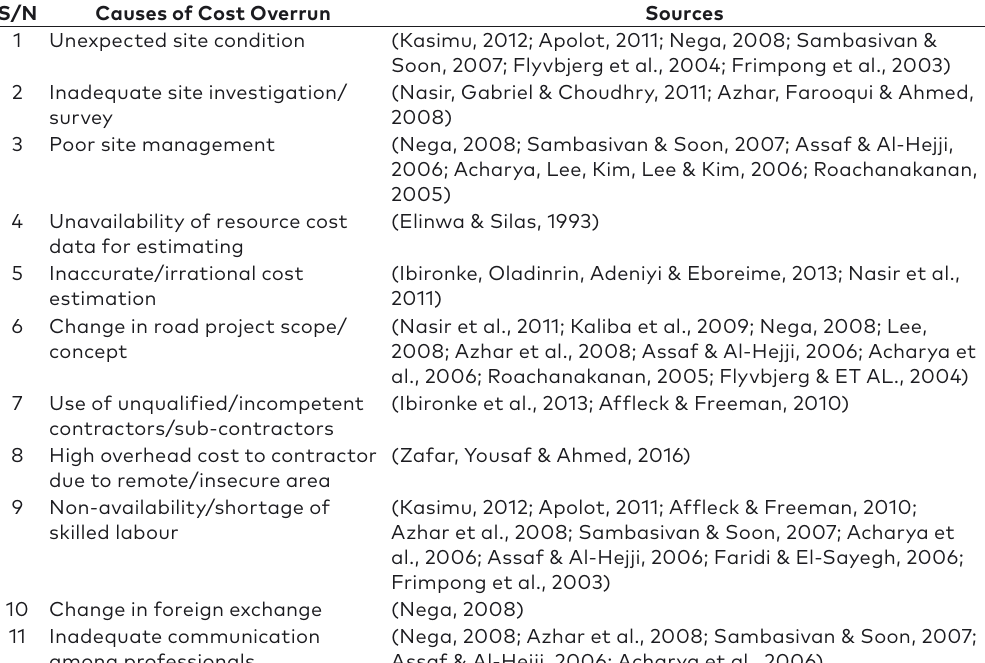
Table 1. Causes of cost overrun on construction